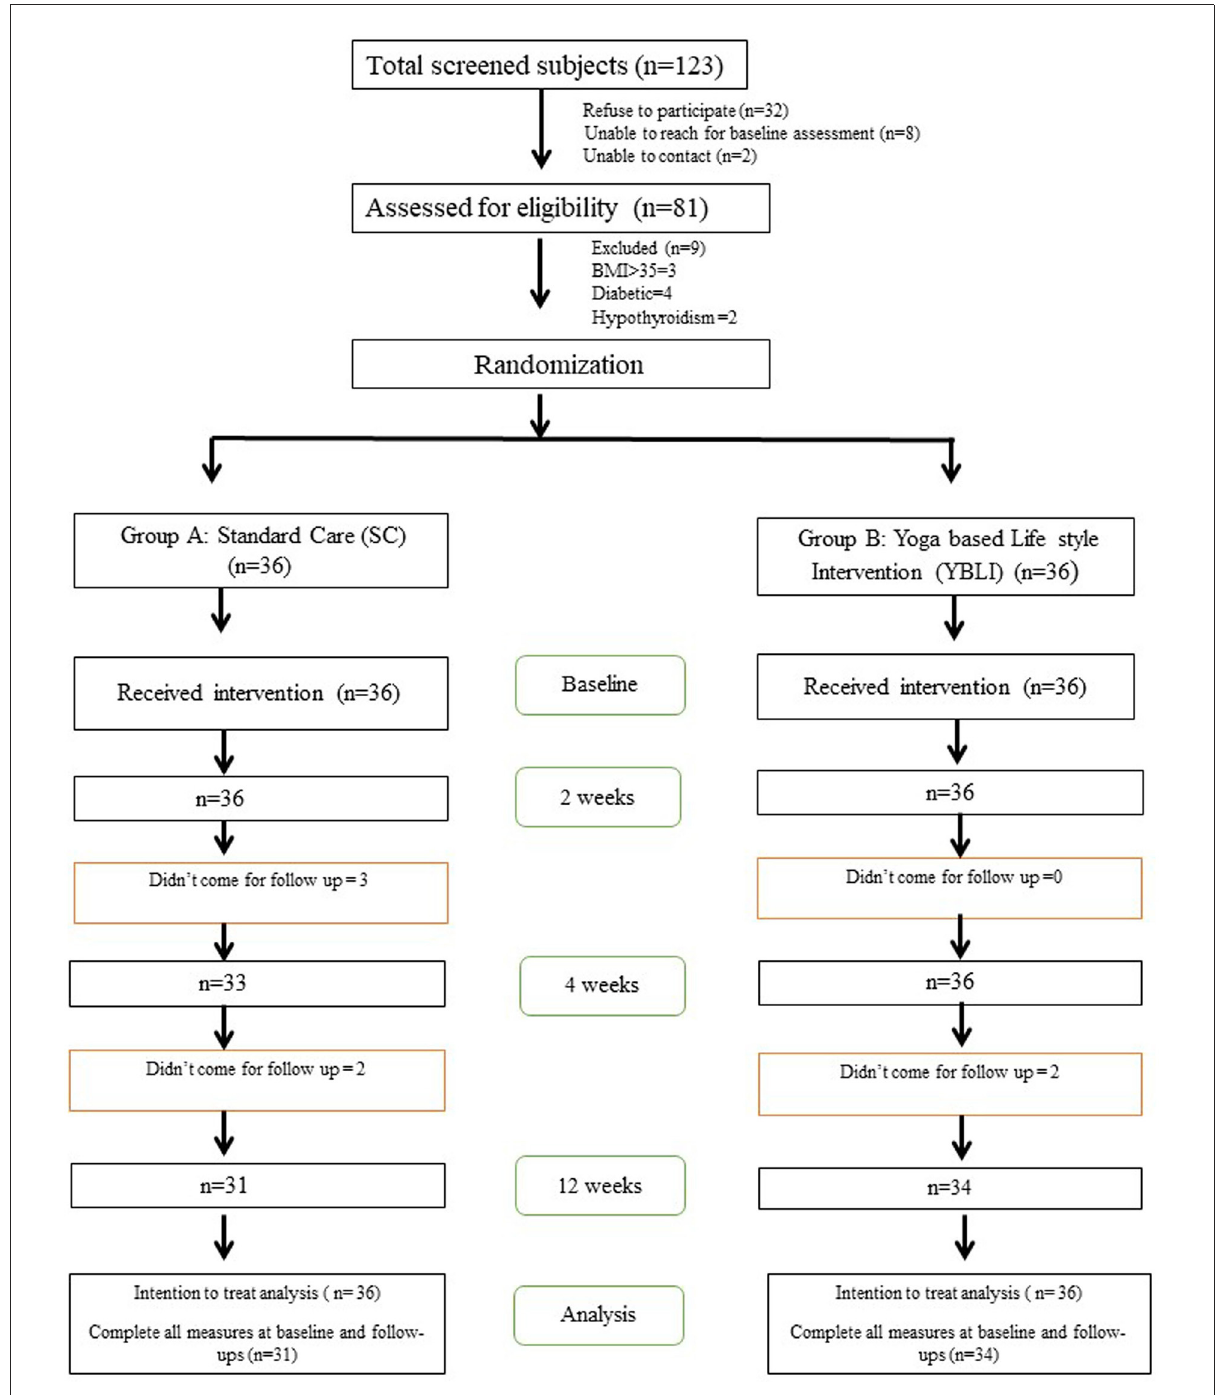
FIGURE1 Study CONSORT flow diagram, consolidated standards of reporting trials, SC, Standard Care; YBLI, Yoga-based lifestyle intervention.